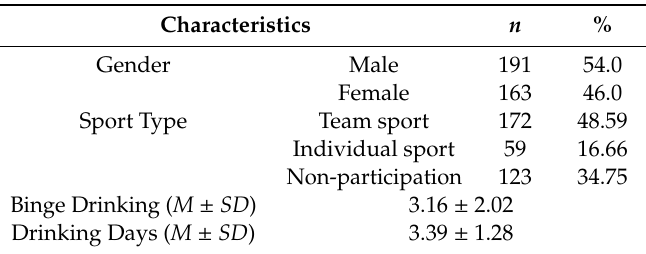
Table 2. General characteristics of the participants.